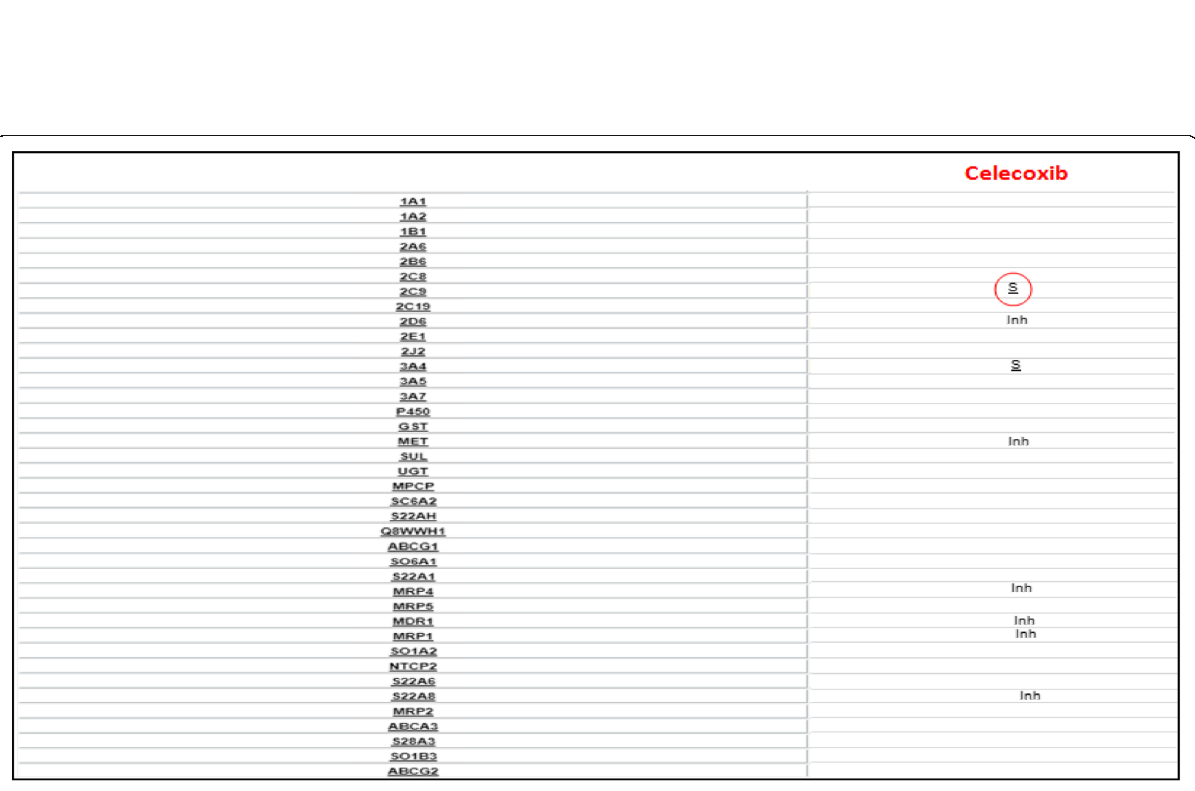
Fig. 2 Celecoxib metabolic profile. In the left column there is the list of drug metabolizing enzymes and drug transporters, one for each row; in the right column relationship between corresponding transporter or enzyme of the row and celecoxib: is indicated by the symbol ‘ S ’ for substrate and ‘ Inh ’ for inhibitor. Enzyme CYP 2C9 is rimmed to emphasize their importance in celecoxib ’ s metabolic destiny. Related page at the website